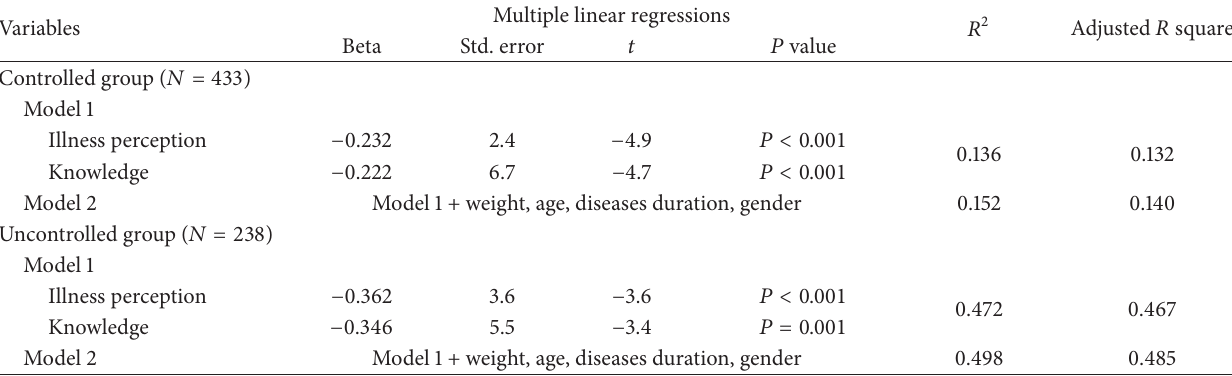
Table 5: Multiple linear regressions of knowledge and illness perception in sodium intake variations (adjusted to energy